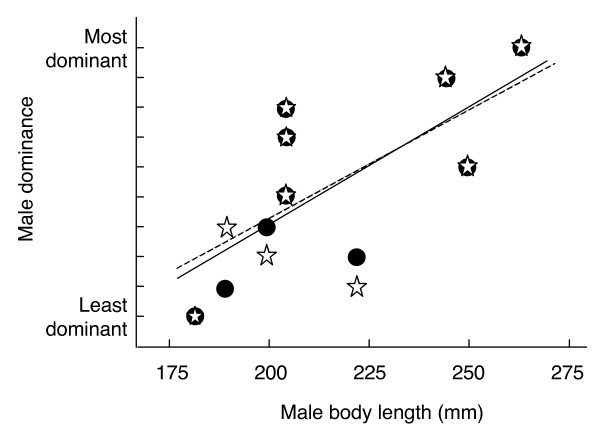
The effect of male body length on dominance in male-male interactions. Dominance is given as David's score (circles and non-dashed regression line) and as Clutton-Brock et al.'s index (stars and dashed line). Both scores are based on 198 antagonistic encounters.